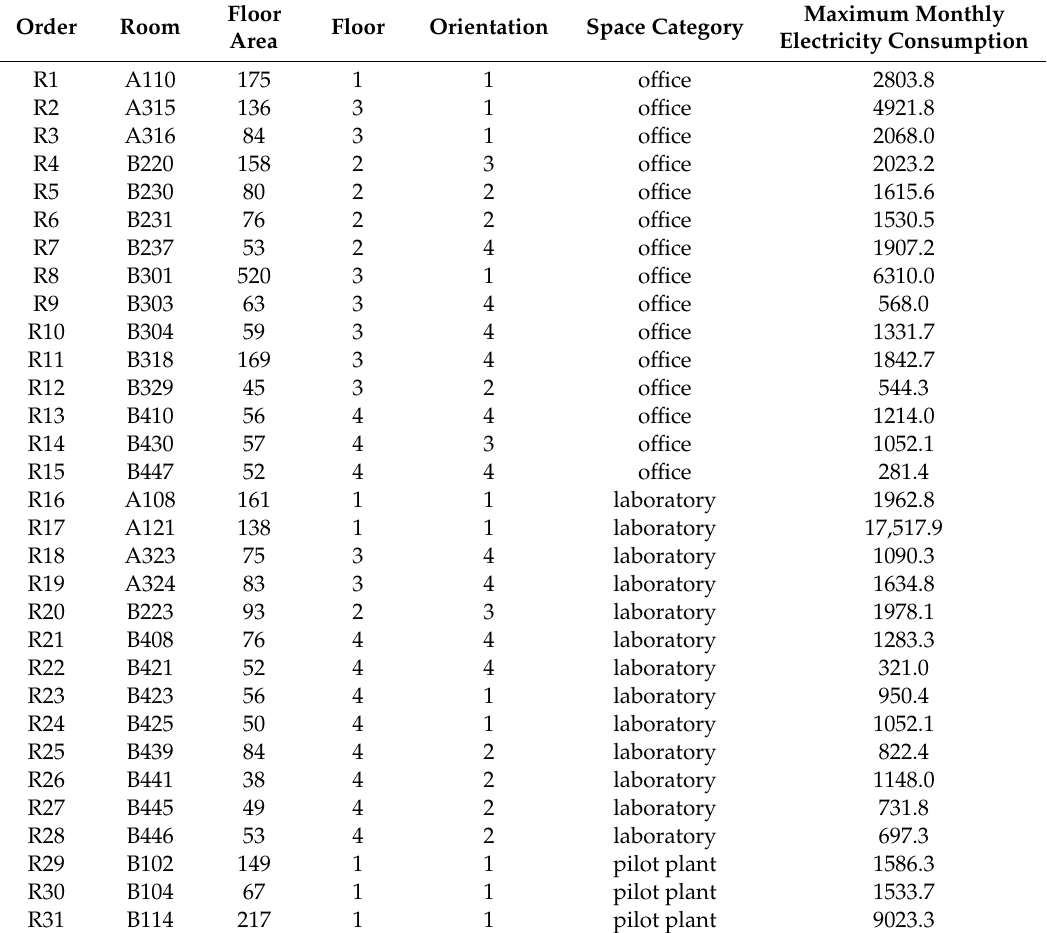
Table 2. Basic information of the selected 31